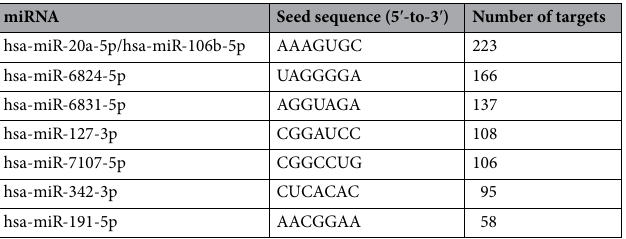
Table 1. Differentially expressed miRNAs (DEMs) with their seed sequences and the number of target